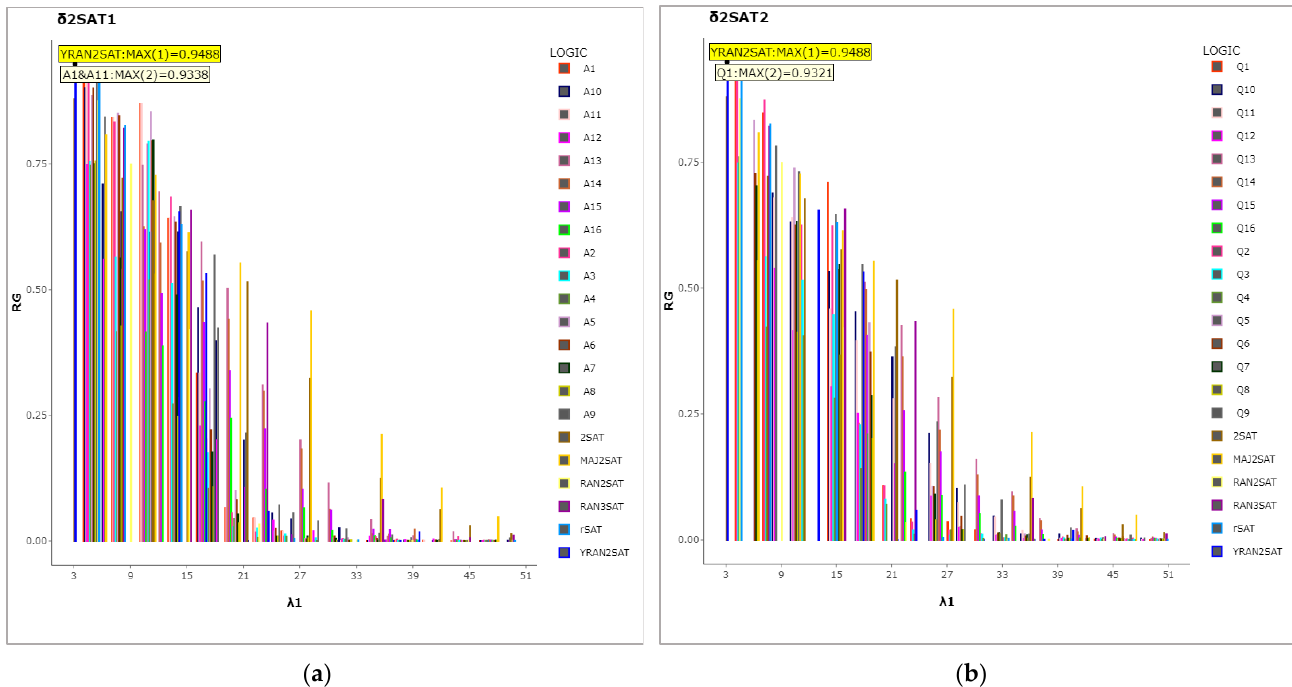
Figure 10. column representation for models in both types of logic ( a ) 1 2 SAT   2 2 SAT   Figure 10. Column representation for models in both types of logic ( a ) δ 1 2 SAT ρ , ( b ) δ 2 2 SAT ρ and and recently developed logic systems. recently developed logic